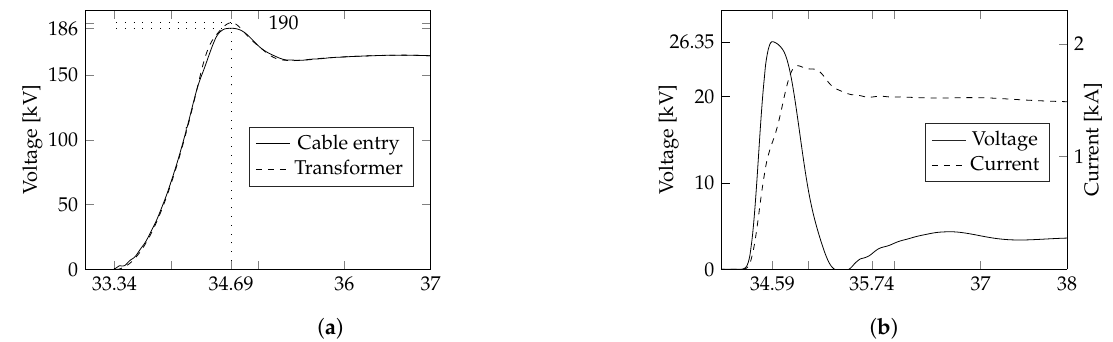
Figure 8. Application case when the grounding system is added: ( a ) the effect in the transmission system; and ( b ) the results at the surge arrester injection